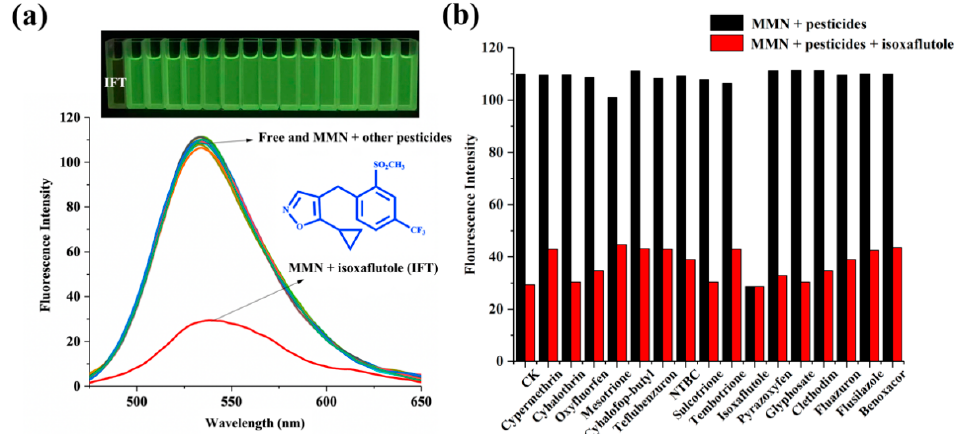
Figure 6. ( a ) Fluorescence spectra changes of the MMN solution (10 μ M) after adding different pesticides (50 µ M). Inset: color changes of MMN solution before and after adding pesticides under UV light of 365 nm. ( b ) Competition selectivity of MMN (10 μ M) toward isoxaflutole (50 μ M) in the presence of other competition pesticides (100 μ M).